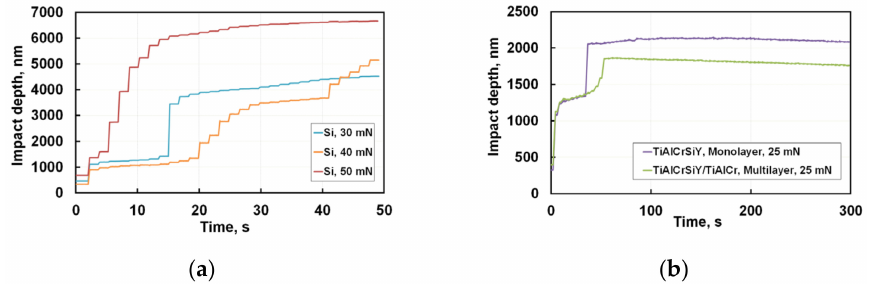
Figure 1. Short-term indenter penetration depth at 30–50 mN, 50 s for Si reference sample ( a ) and for monolayer and multilayer coatings at 25 mN, 300 s ( b